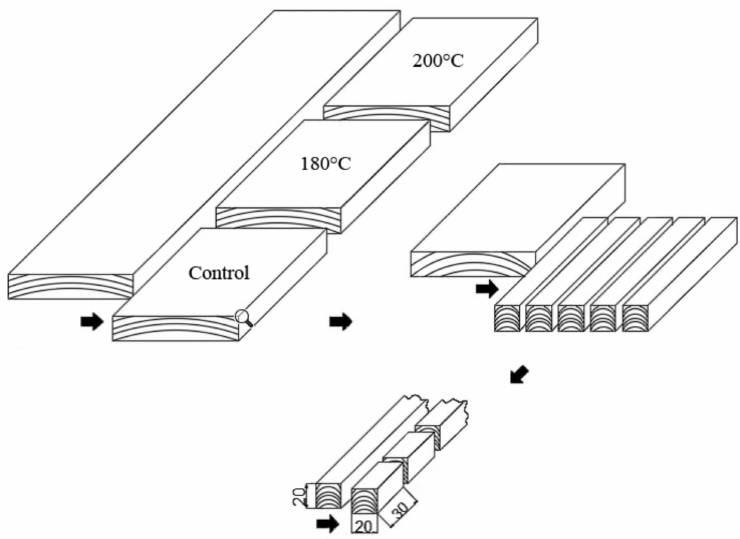
Figure 1. The sample preparation